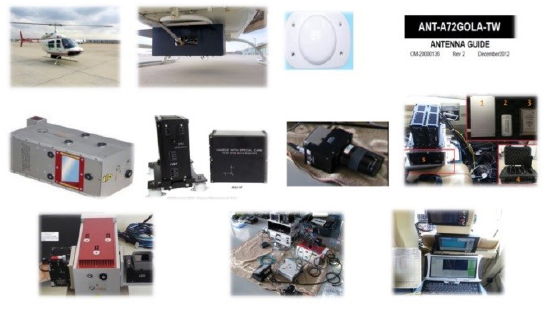
Figure 3: Data acquisition system - LiDAR For the area of Istanbul, corresponding to about 16,000 map sheets of 1/1000 scale, adjusted and classified LAS data, digital elevation model, digital surface model and 1/1000 scale linear maps with contour lines were produced. The LiDAR data with